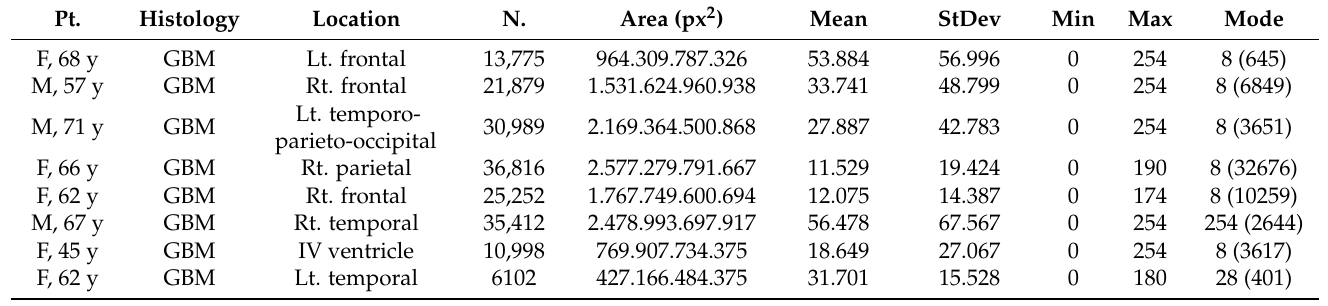
Table 2. Data from first-order radiomic analysis performed with ImageJ on the first eight GBM patients according to and for the refinement of the proposed protocol. Pt : patient, sex, and age; N .: number of pixels analyzed; Area : area of the rectangular selection for analysis; Mean , StDev , Min , Max , Mode : these data refer to the intensity value from 255 to 0 of each pixel within the selected area on 8-b gray images according to gray tone.